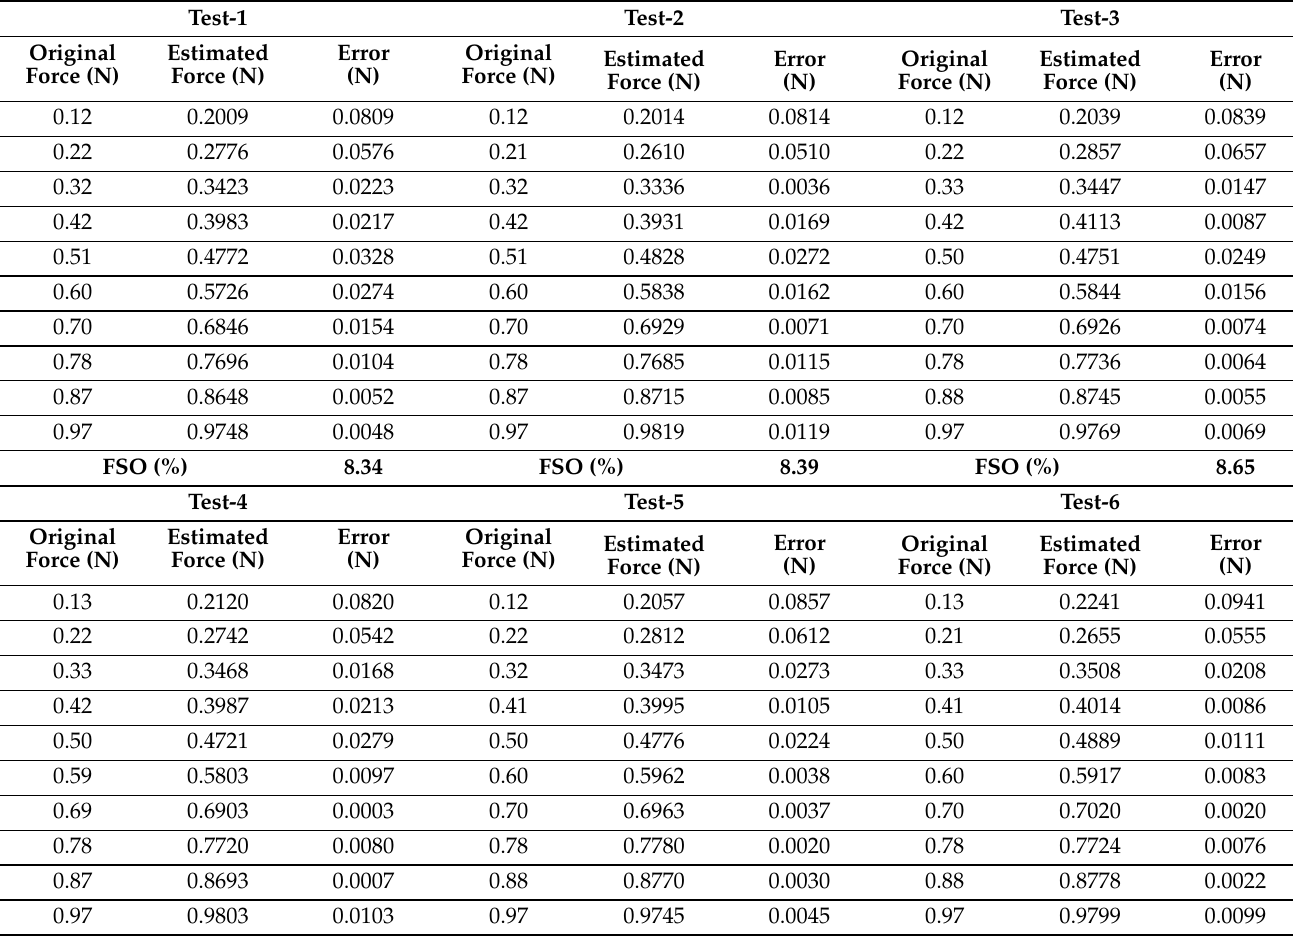
Table A1. Force distribution estimation w.r.t 10 different tests under force ranges (0.1 N ∼ 1